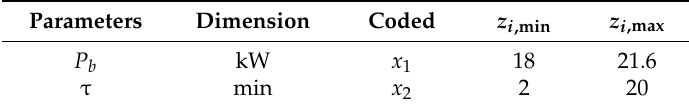
Table 1. Ranges for process parameter values of the e-beam melting of Ta. Parameters